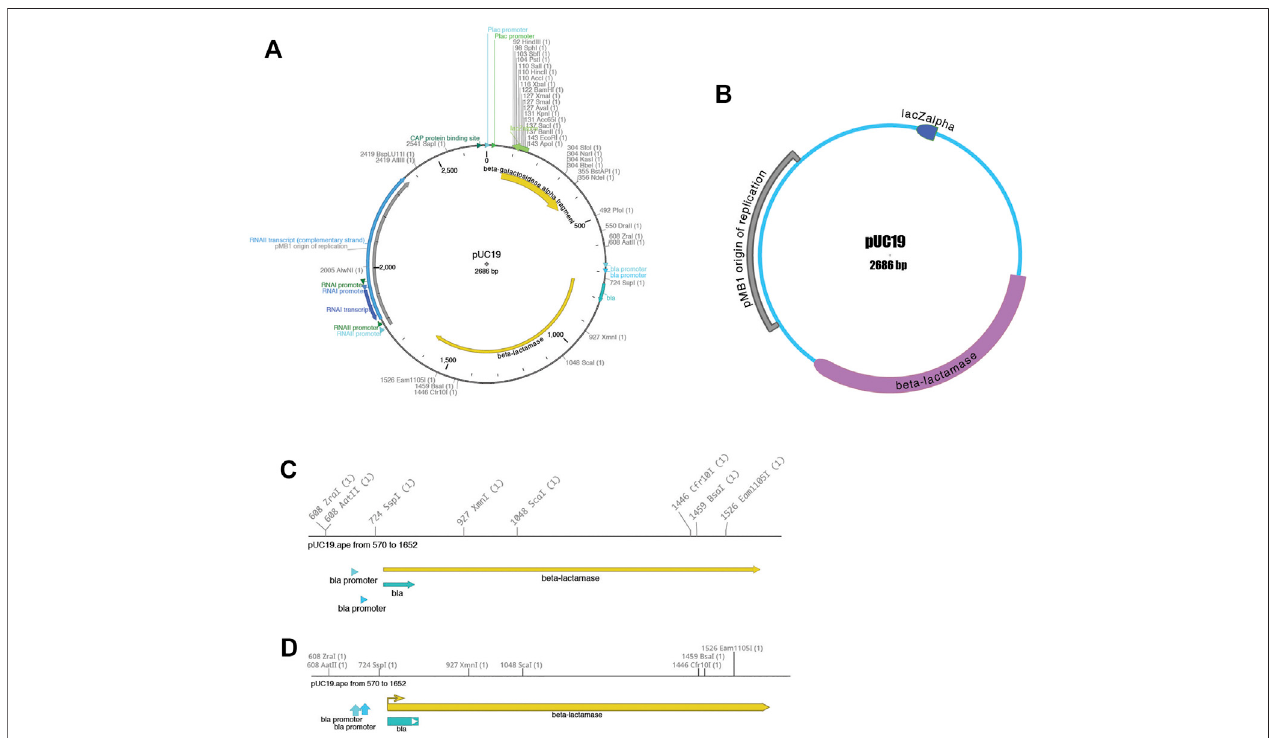
FIGURE2| Graphicalmapsofasequence. (A) AcircularmapofpUC19,withcoloredfeaturesandrestrictionenzymesites. (B) Adifferentcircularmapofthesame sequence fi le showing a variety of user-con fi gurable display properties. (C) A linear map of a region of the same pUC19 fi le. (D) Another linear map of the same region, showing a variety of user-con fi gurable display